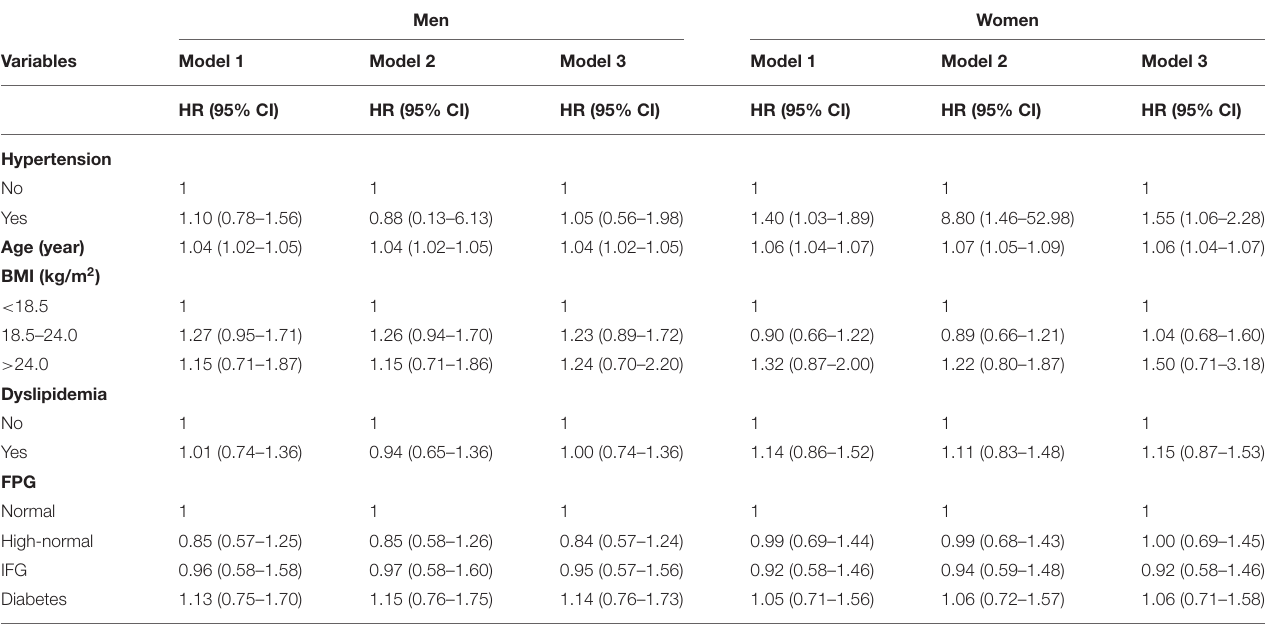
TABLE 3 | Analysis of variables that may affect the association between hypertension and risk of carotid